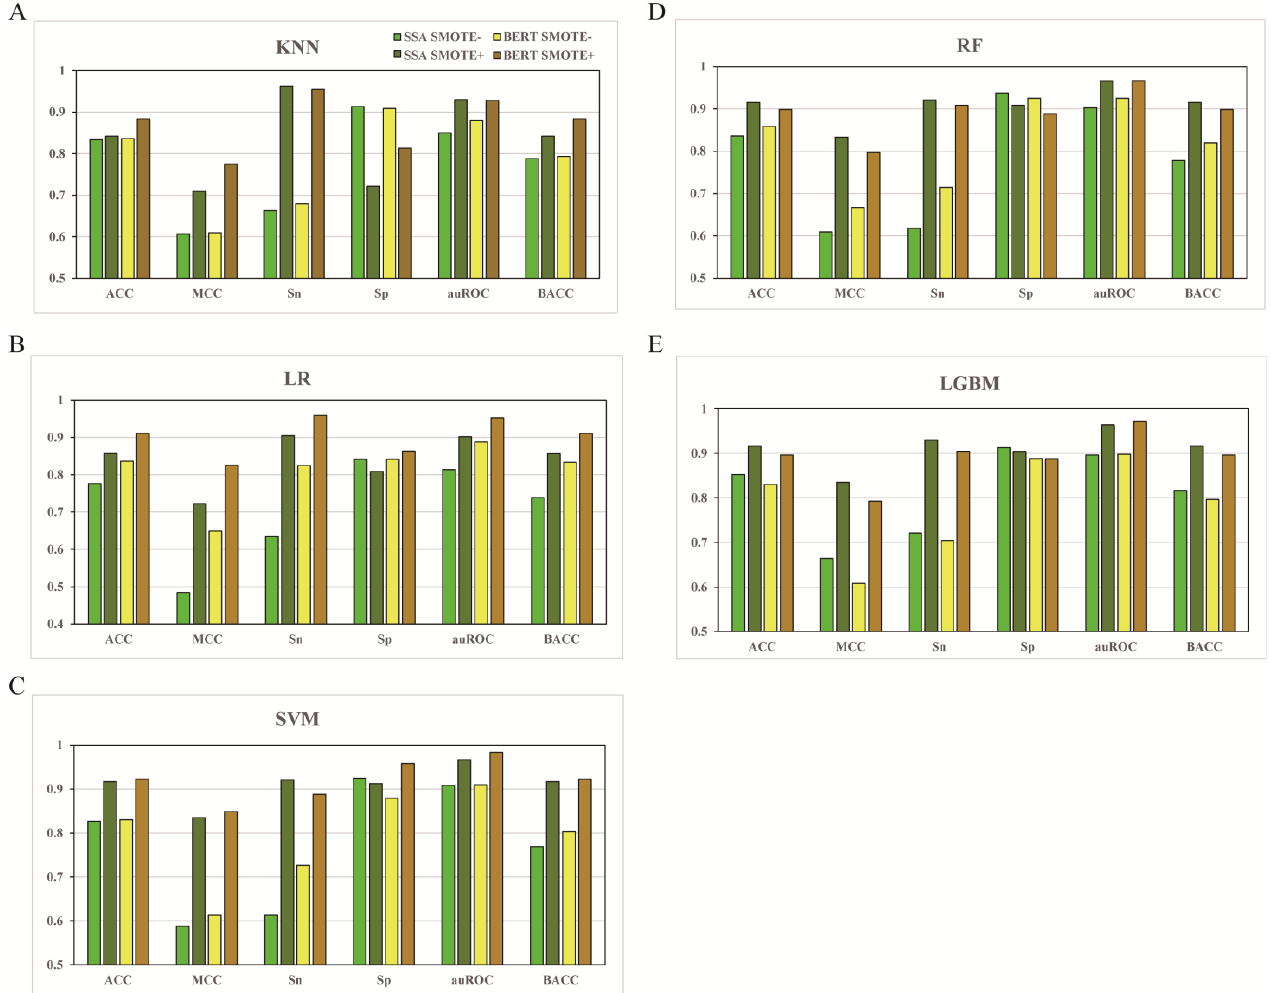
Figure 2. The performance of 10-fold cross-validation metrics of SSA and BERT features using different algorithms pretrained with or without SMOTE. ( A ) KNN; ( B ) LR; ( C ) SVM; ( D ) RF; ( E ) LGBM.